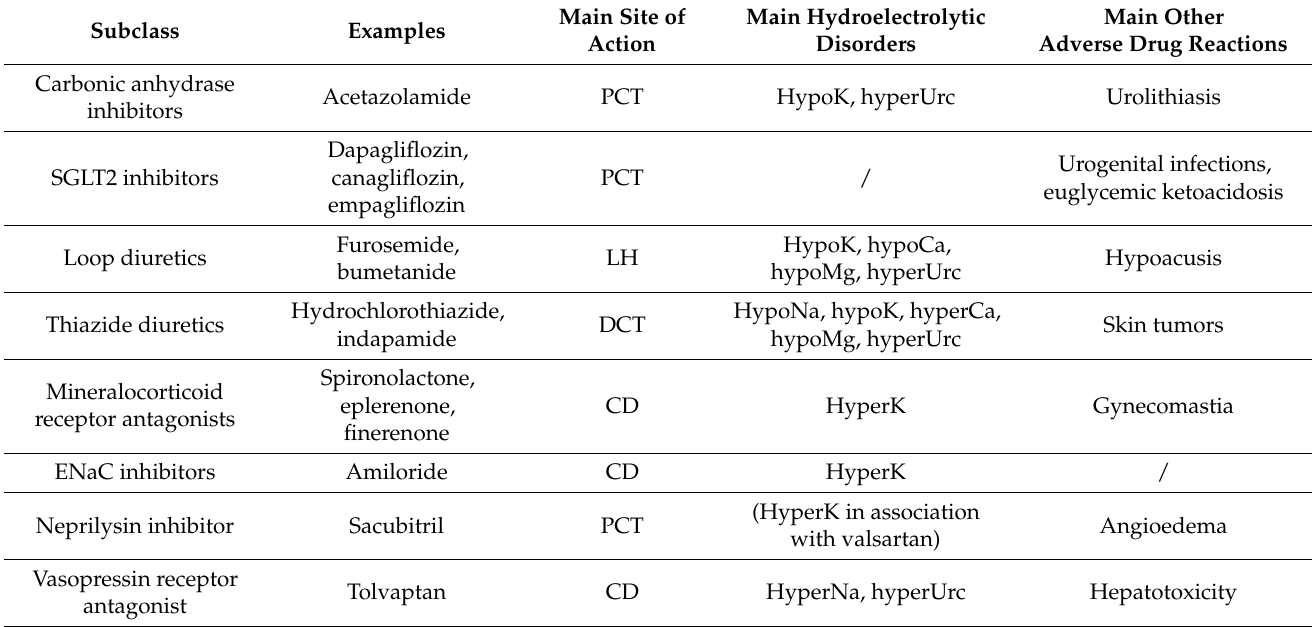
Table 1. Comparison of different diuretic subclasses. Virtually all diuretics can precipitate prerenal acute kidney injury. PCT: proximal convoluted tubule, LH: loop of Henle, DCT: distal convoluted tubule, CD: collecting duct, Na: natremia, K: kalemia, Ca: calcemia, Mg: magnesemia, Urc: